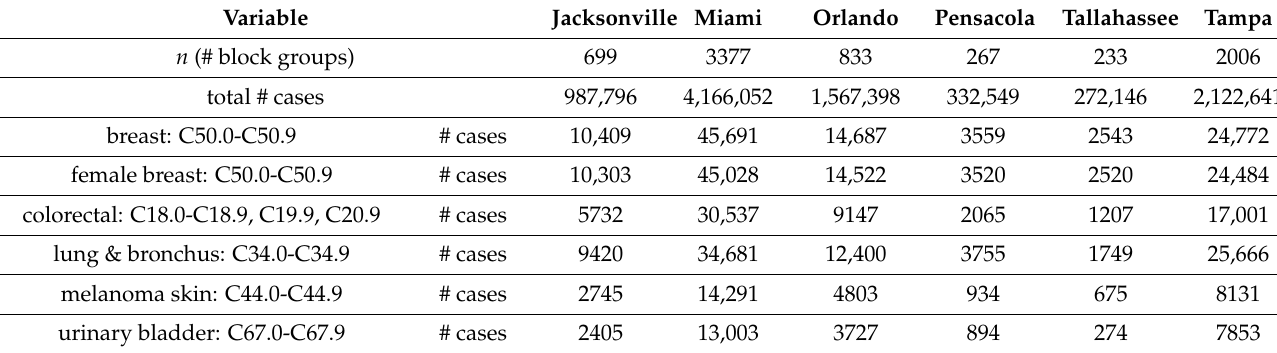
Table 2. Case counts for selected cancer